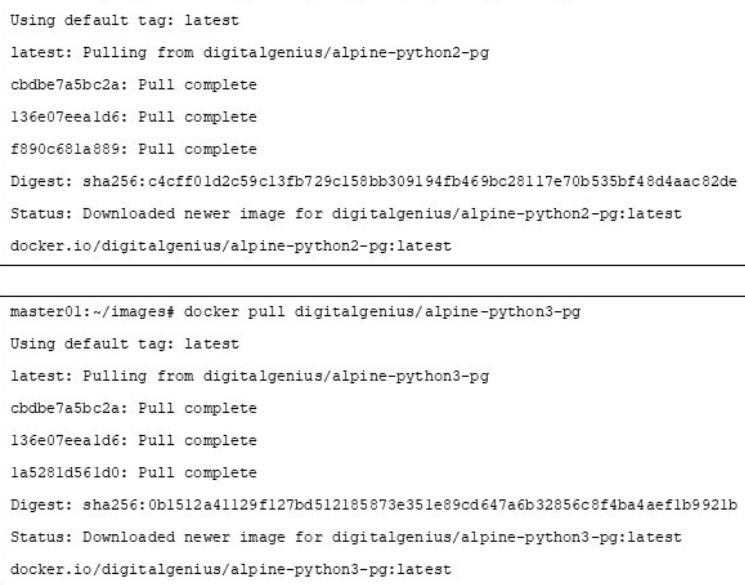
Figure 6. Independent Image Download.